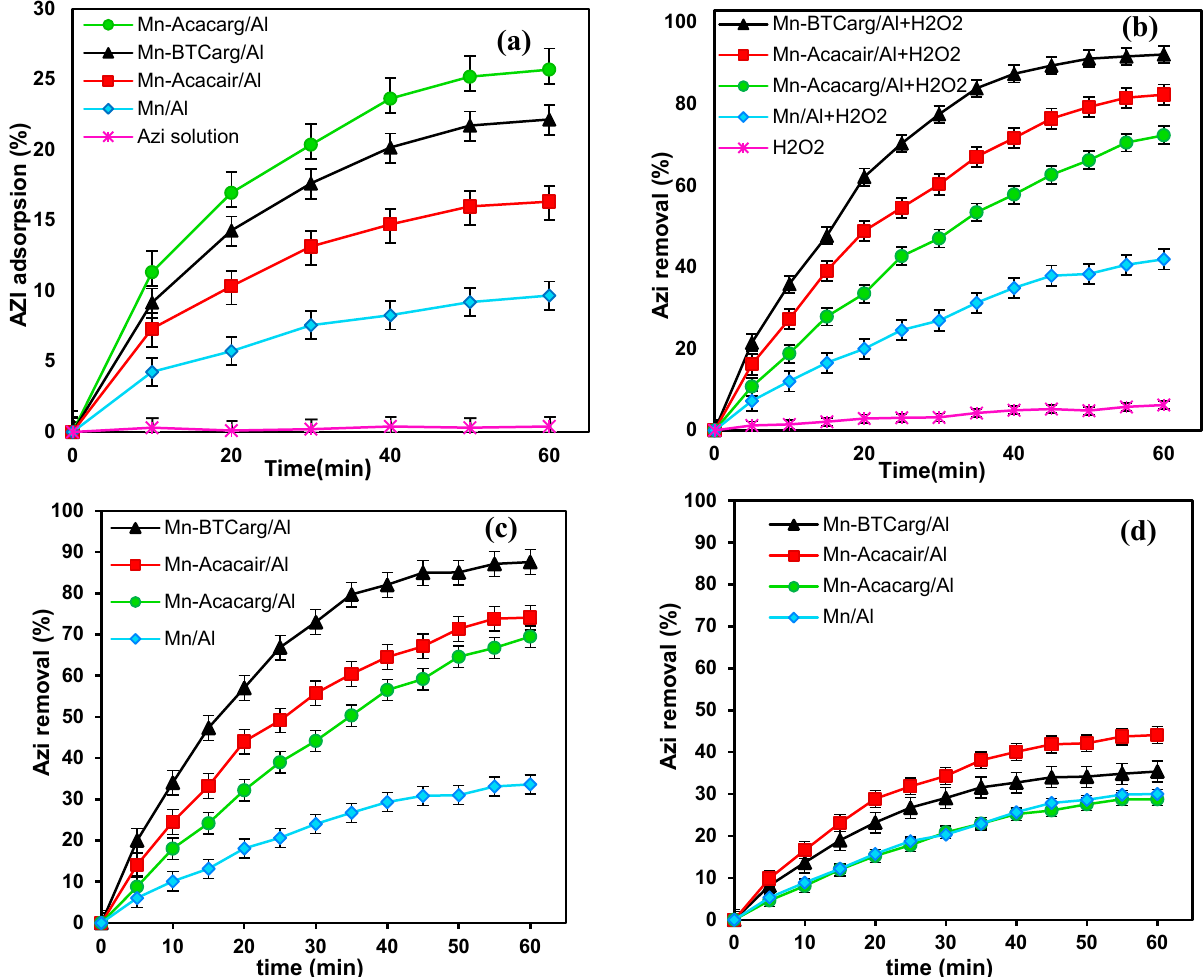
Figure 7. ( a ) The Azi adsorption: pH = 7, catalyst dose of 5 g/L, and Azi initial concentration of 0.1 g/L in the absence of H 2 O 2 ; ( b ) Azi removal, ( c ) Effect of isopropanol on Azi removal and ( d ) Effect of P-benzoquinone (BQ) on Azi removal: pH = 7, catalyst dose of 5 g/L, and Azi concentra- tion of 0.1 g/L, H 2 O 2 concentration of 5